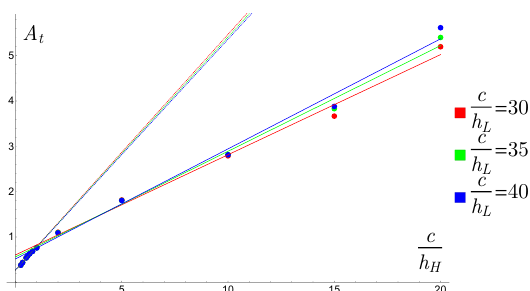
Figure 22 . This is a version of (cid:12)gure 12 where we have zoomed out to show the small h H region. c The zoomed-out points with c = (30 ; 35 ; 40) more closely (cid:12)t slopes (0 : 221 ; 0 : 233 ; 0 : 242), which are h L shown as solid lines; the (0 : 521 ; 0 : 515 ; 0 : 509) (cid:12)ts for large h H are shown as dotted lines. c